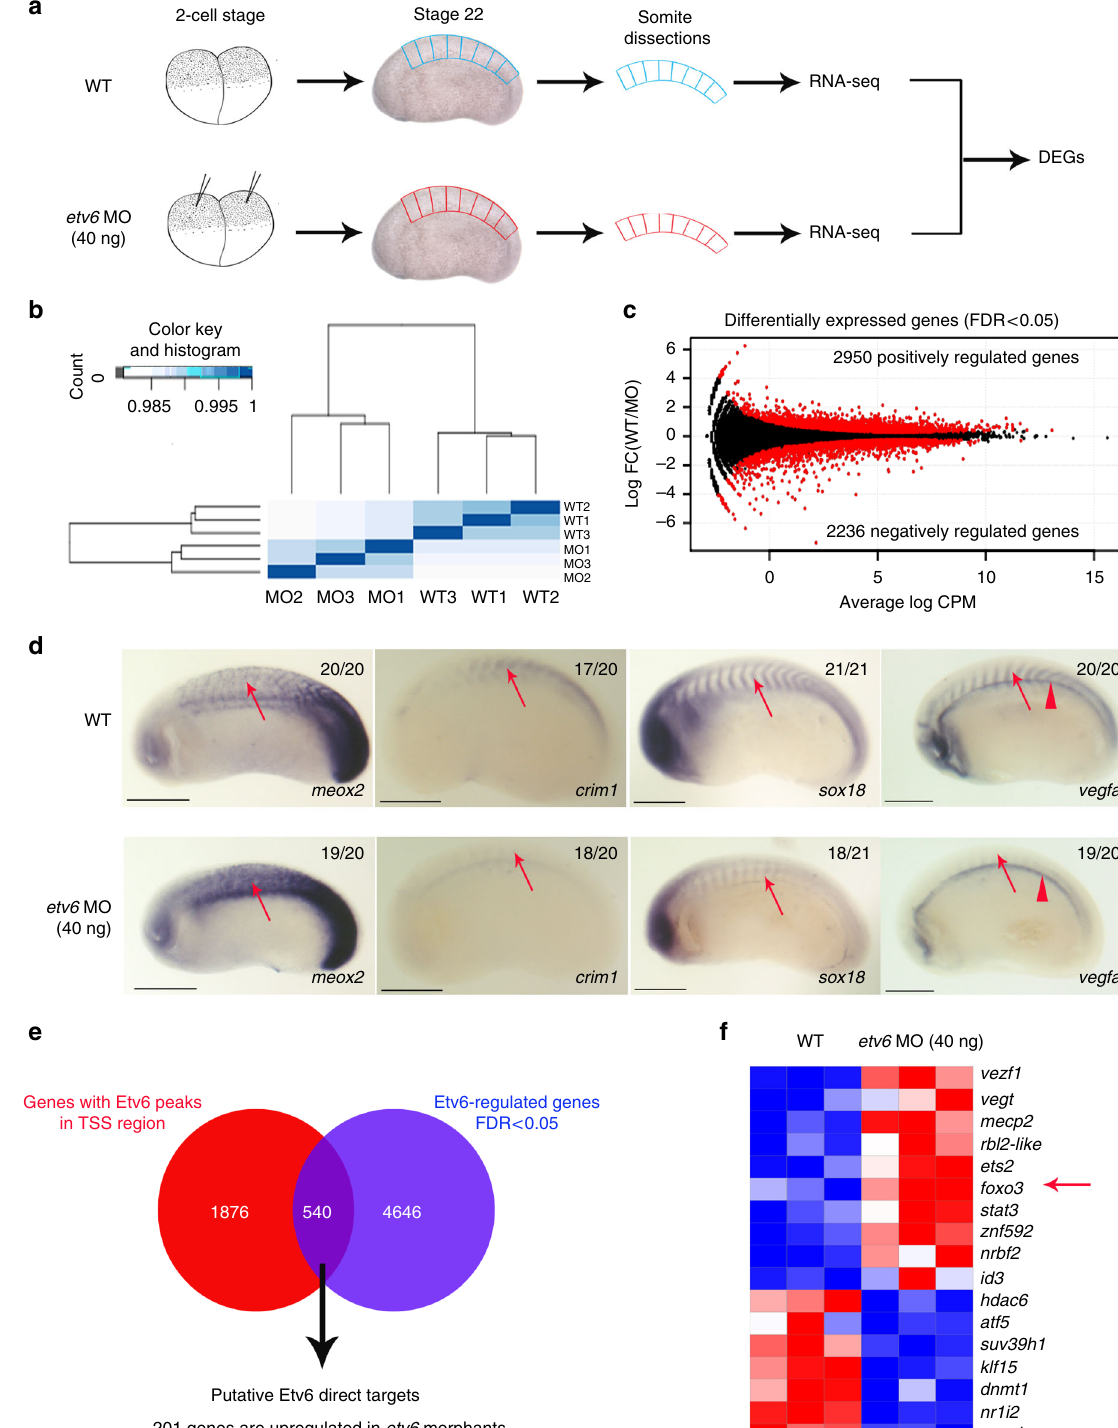
(Fig. 2d). During vertebrate development, the homeobox genes meox1 and meox2 regulate somitogenesis and myogenesis 31 . In zebra fi sh, meox1 also represses the expansion of somite-derived endothelial cells thereby limiting HSC development in the DA 32 . The single Xenopus meox gene is repressed by Etv6 in somites (WT/ etv6 MO log 2 FC = − 0.89 for meox2.L and − 0.53